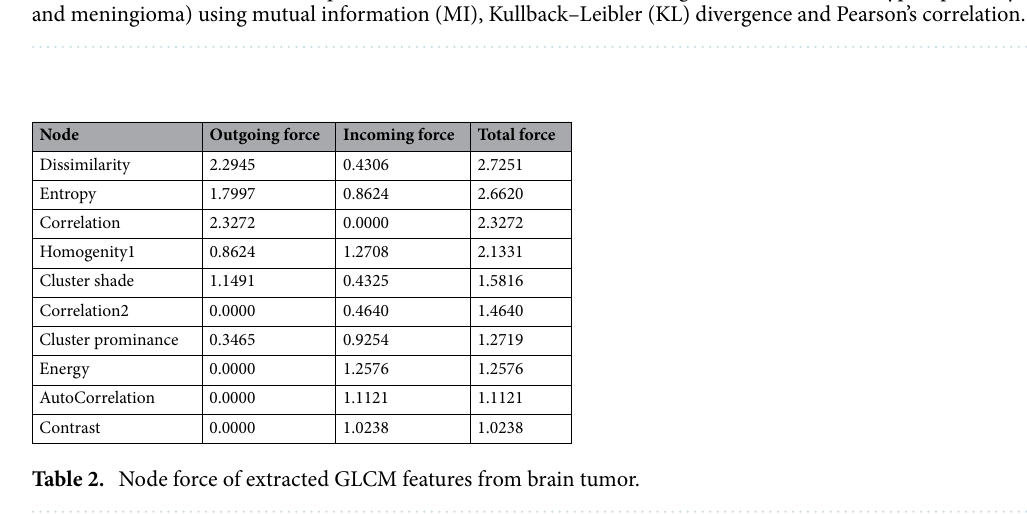
Table 1. Parent child relationship on extracted GLCM features to distinguish the brain tumor types (pituitary and meningioma) using mutual information (MI), Kullback–Leibler (KL) divergence and Pearson’s correlation.